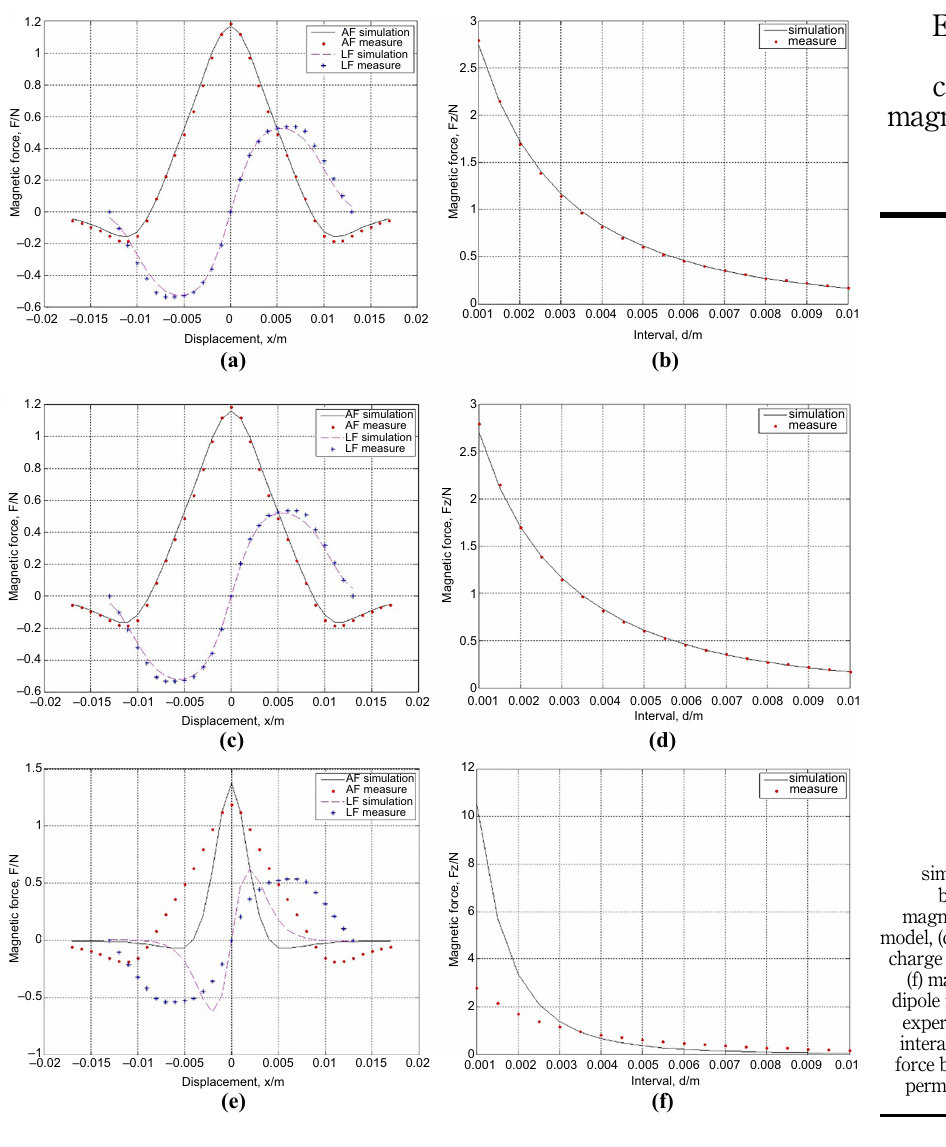
cylindrical and spherical permanent magnets. However, magnetic dipole – dipole model is only appropriate for spherical permanent magnet instead of the cubic or cylindrical magnet, because dipole model cannot describe the specific shape of permanent magnet, only sphere is the topological form of a dipole as a filled dot. Lots of applications could refer to our work, which is valuable for choosing the most appropriate model to solve the problems on magnetic force calculation based on permanent magnets with different kinds of shapes.